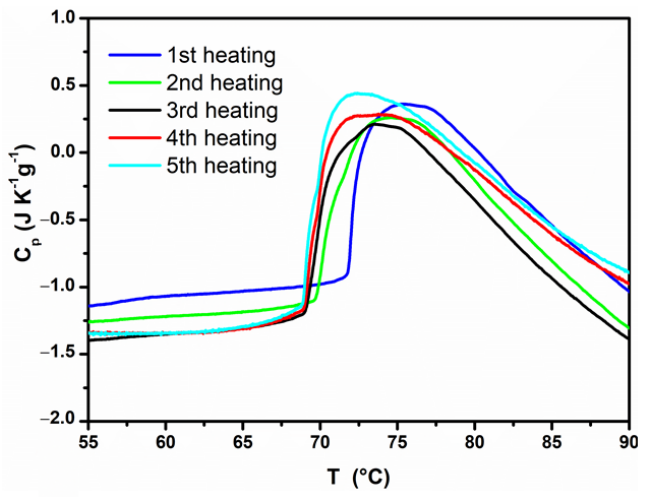
Figure 5. Reversibility of the aggregation process for pEFS8-26 aqueous solutions (1 g/L), studied by nano-differential scanning calorimetry (n-DSC). The first three scans were carried out at 1 °C/min, and the last two at 0.5 °C/min.